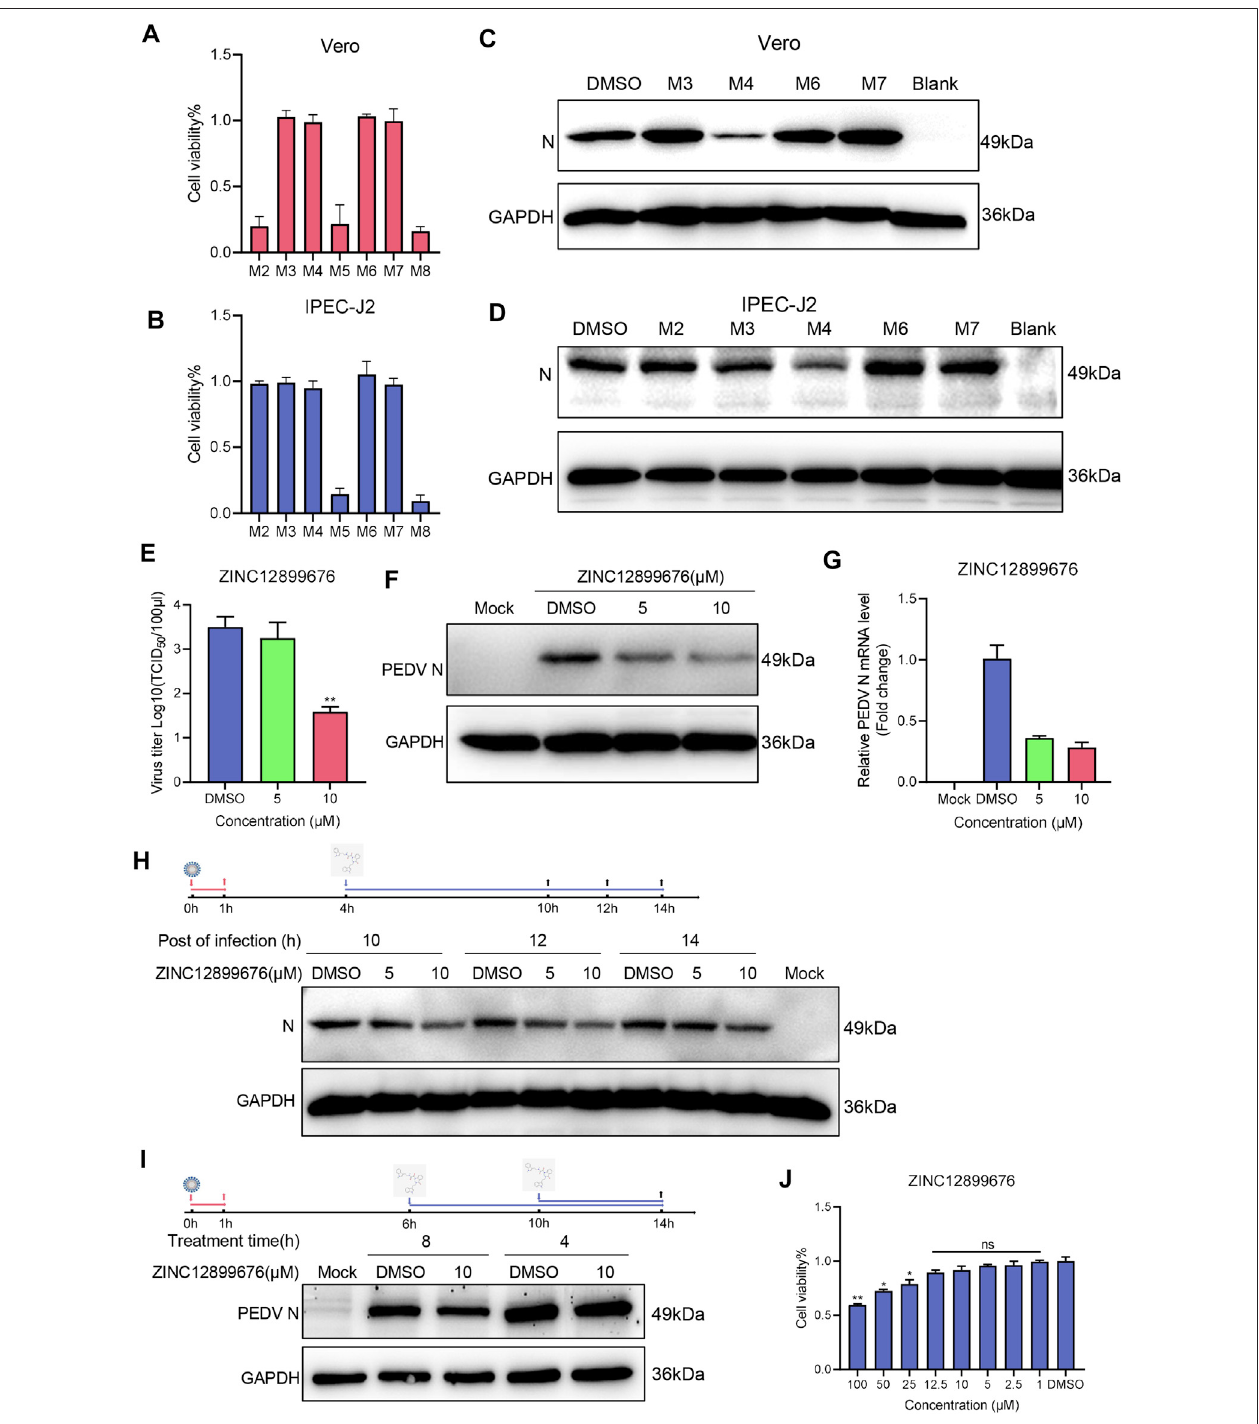
FIGURE 4 | ZINC12899676 has antiviral activity against PEDV in vitro . (A , B) Cell viability of Vero and IPEC-J2 cells pretreated with compounds (10 μ M) and incubated for 24 h. The results are from one ofthree independentexperiments. (C , D) Vero and IPEC-J2 cells werepretreated withcompounds(10 μ M) for 1 h and then infected with PEDV for 1 h at 37 ° C. The cells were washed with PBS and then incubated in a fresh medium containing compounds for 16 h. DMSO served as the treatment control. (E – G) IPEC-J2 cells were pretreated with the indicated concentrations of ZINC12899676 for 1 h and then infected with PEDV for 1 h at 37 ° C. The cells were washed with PBS and then incubated in fresh medium containing ZINC12899676 for 16 h. DMSO served as the treatment control. (E) Culture supernatants were collected at indicated time points for viral titration. Results are expressed as TCID 50 . Titers from three independent experiments are shown as means ± SD (error bars). (F) Western blot for the viral N-protein in cells infected with PEDV and treated with indicated concentrations of ZINC12899676 or DMSO, at